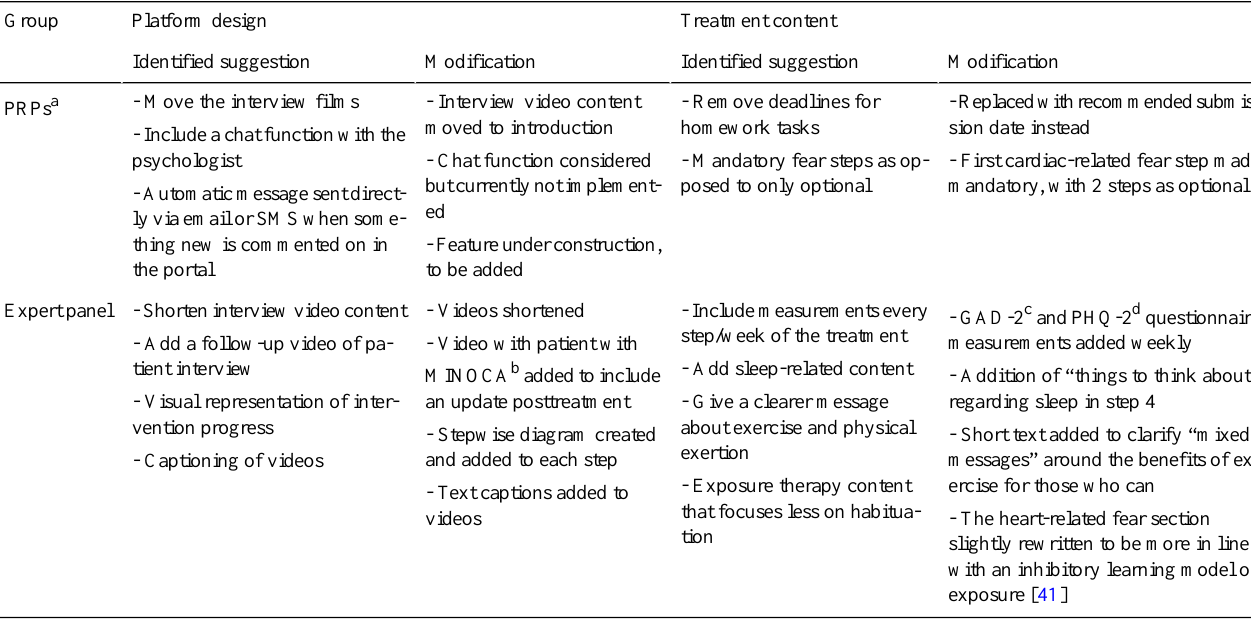
Table 2. Suggested changes made by patient research partners and the expert panel regarding the design and content of the intervention.